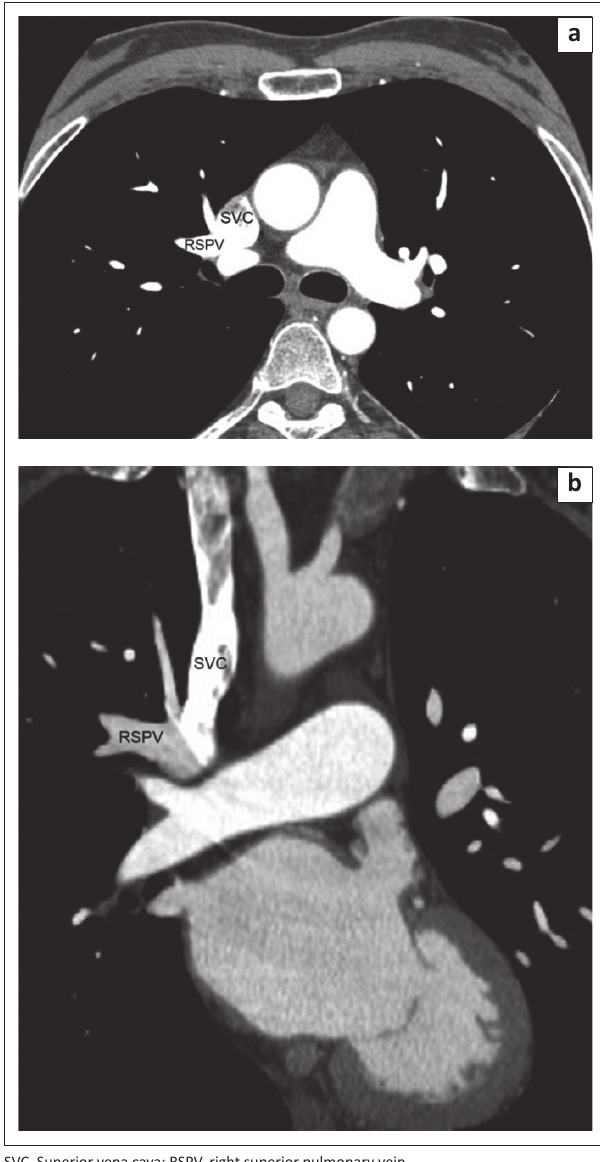
b SVC, Superior vena cava; RSPV, right superior pulmonary vein. FIGURE 13: Partial anomalous pulmonary venous return in a 49-year-old man. The right superior pulmonary drains directly into the superior vena cava (SVC): (a) Axial image; (b) Oblique coronal